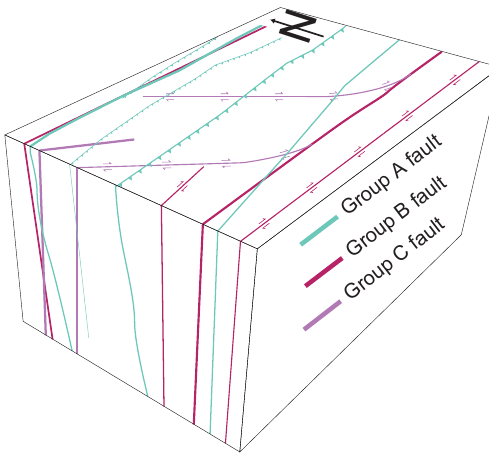
Figure 2. Schematic bloc diagram showing geometrical relation- ships between faults of different orientation groups (modified after Wehrens et al.,